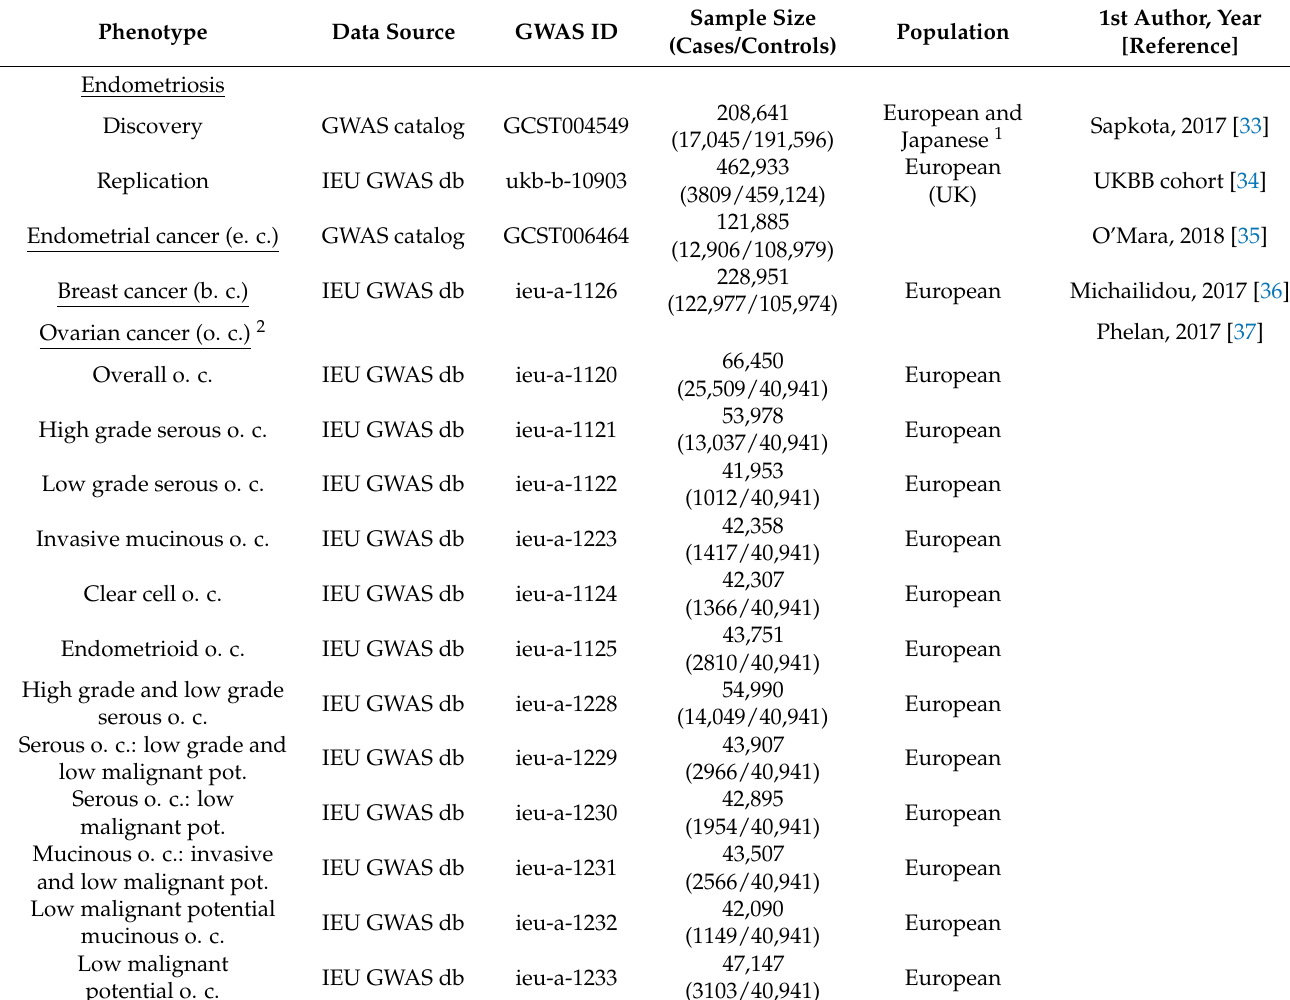
Table 3. Description of GWAS used in each